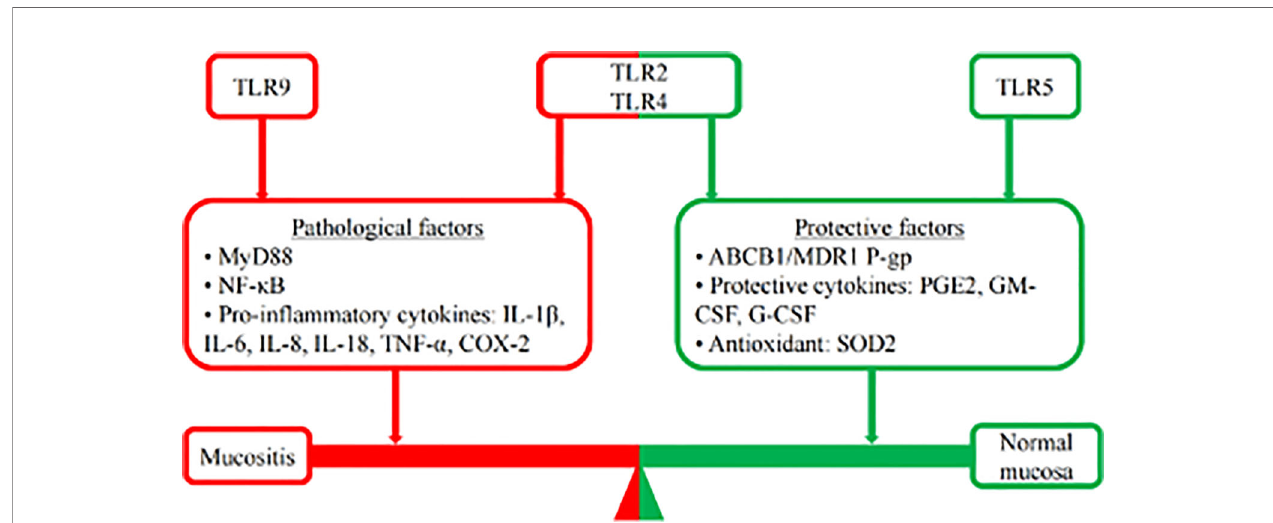
FIGURE 3 | Mucosis balance. The mucositis process is recognized as a balance between pathological factors and protective factors. Following chemotherapy, TLR9 recognizes the microbiota and increases the expression of proin fl ammatory cytokines, such as NF- k B, IL-1, IL-18, and COX-2, to promote the development of mucositis. In contrast, TLR5 could suppress the oxidative stress of ROS to contribute to the restoration of RIOM/CIOM by inducing SOD2 and G-CSF. The role of TLR2 and TLR4 seems to be controversial. TLR2 and TLR4 could not only upregulate NF- k B to contribute to the increase in pathological factors (IL-1 b , IL-6, IL-8, TNF- a , etc. ) through the MyD88 signaling pathway, promoting RIOM/CIOM but also inducing ABCB1/MDR1 P-gp and protective cytokines (PGE2, GM-CSF, G- CSF, etc. ) to promote the restoration of normal